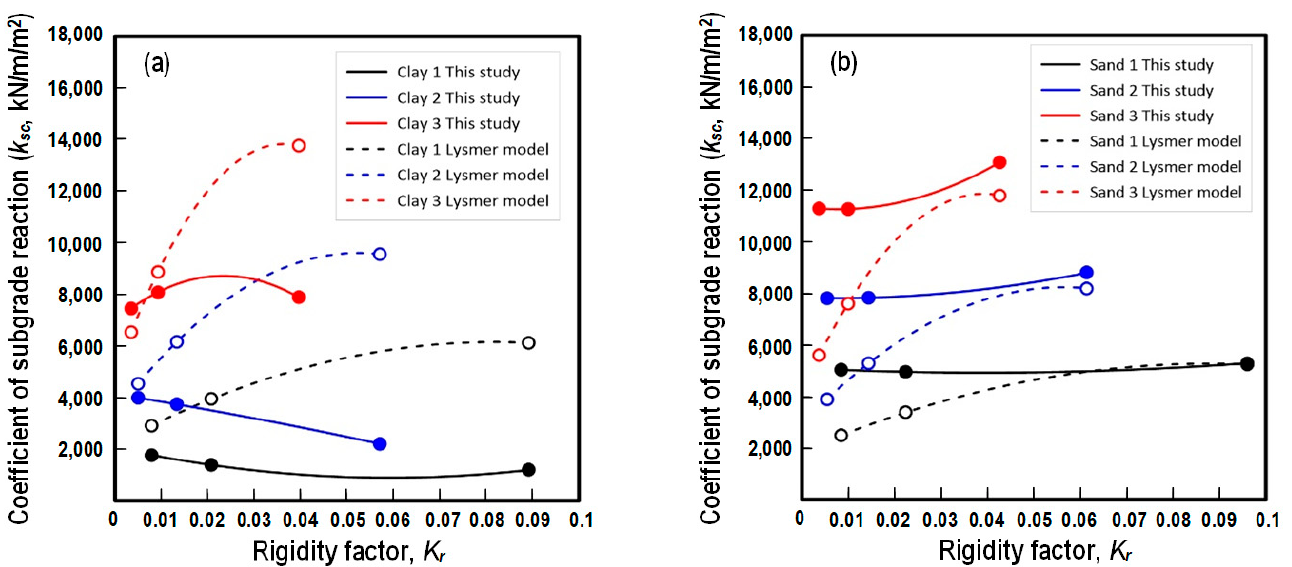
Figure 9. Comparisons of the coefficient of subgrade reaction k sc at the foundation center from this study and those from Lysmer’s model varying with foundation dimensions: ( a ) rafts in clays, ( b ) rafts in sands.